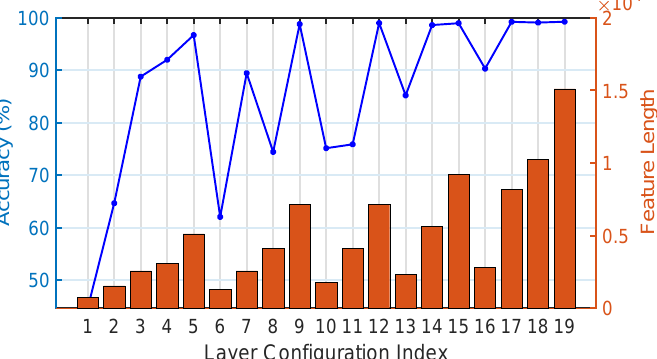
Figure 6. Accuracy and feature length for different layer configurations in Table